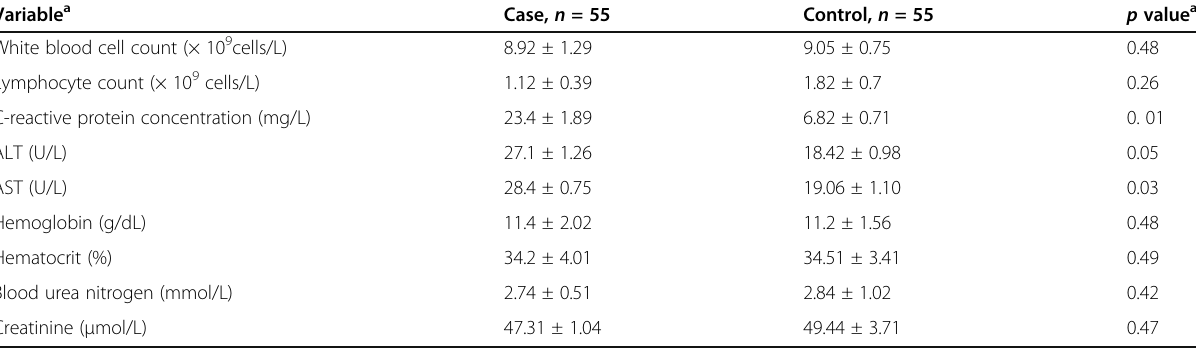
Table 4 Laboratory